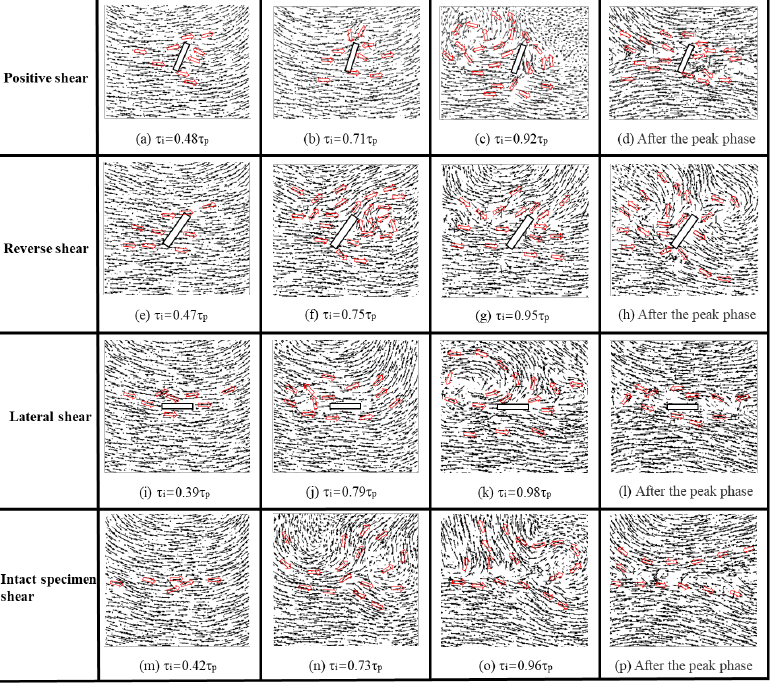
Figure 17. Distribution rules of particle velocity vectors of four model samples at different stages.